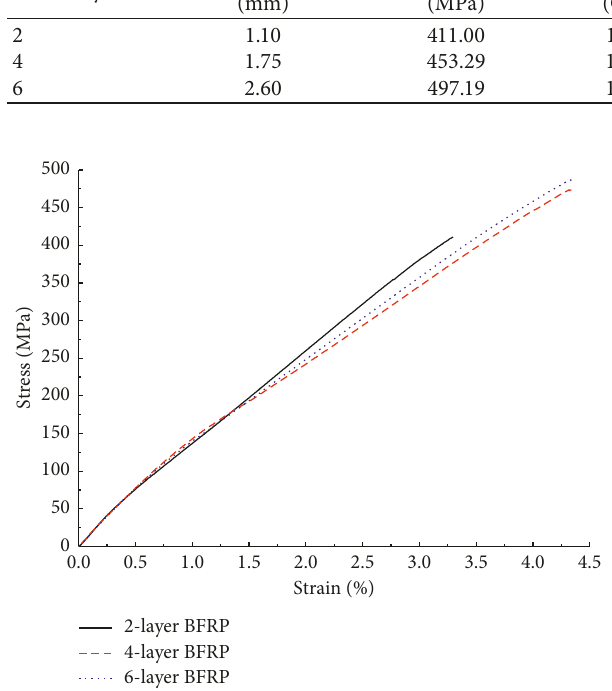
Figure 2: Stress-strain relationship of BFRP. Table 2: Test matrix of specimens with a height of 520mm and an inner diameter of 100mm.